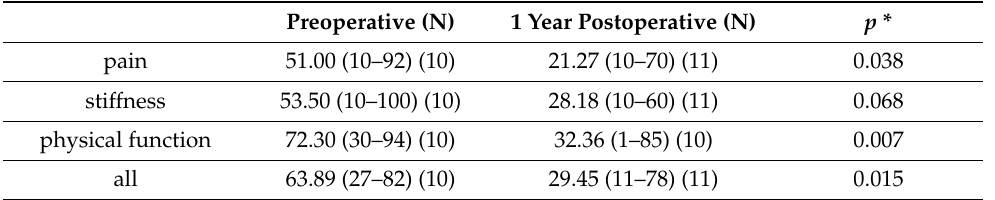
Table 2. Patient-reported function assessment with the Western Ontario and McMaster Universities Arthritis Index (WOMAC) score (number = N); * only complete pairs were